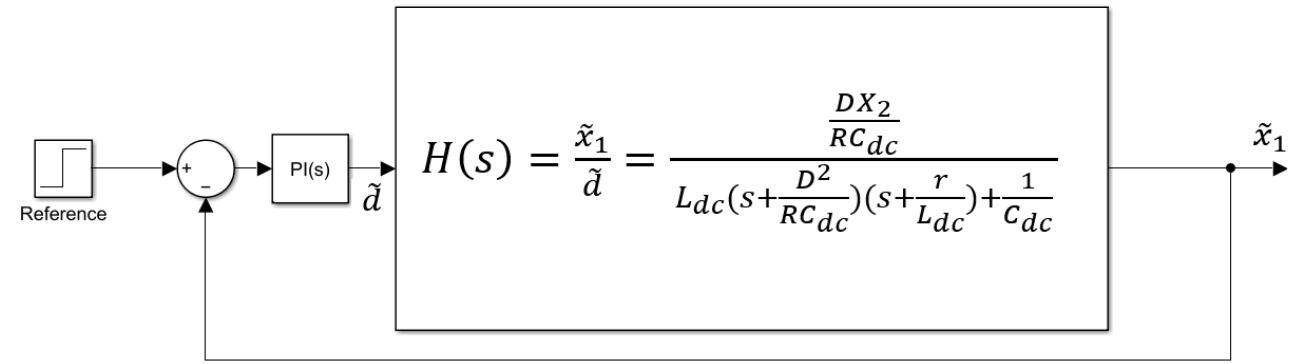
Figure 3. Linear closed-loop control of the EMA emulator.